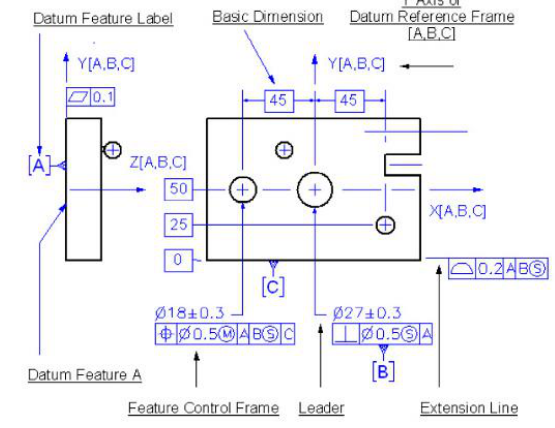
Figure 6: GD&T description of a simple part (Source: Bill Tandler, Multimetrics Inc.)